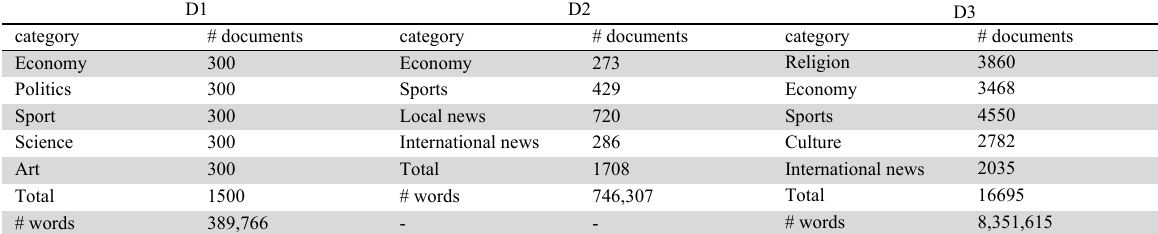
Distribution of the experimental text datasets